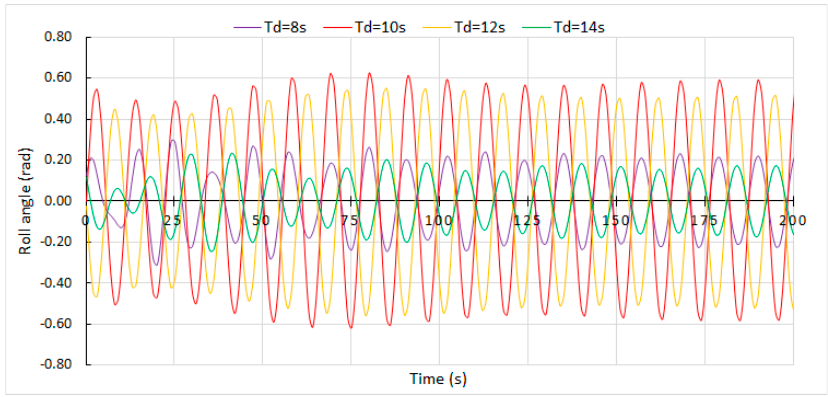
Figure 7. Rolling angles reached by di ff erent ship loading conditions for Tw = 11 s.